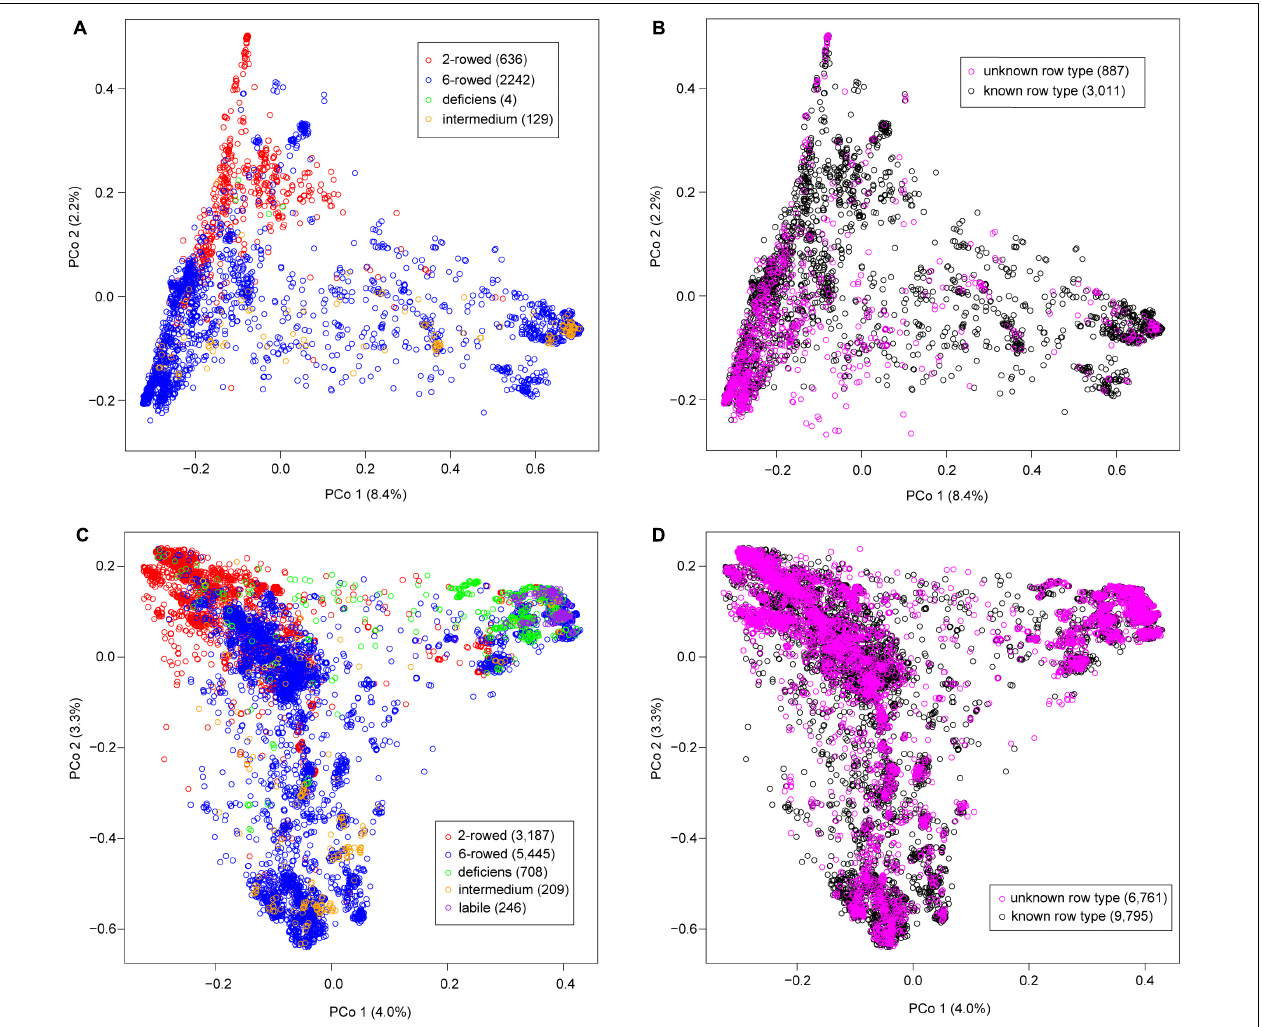
FIGURE 1 | Principal coordinate analysis based on the Rogers’ distance matrix among the 3,898 winter (A,B) and 16,556 spring barley accessions (C,D) . (A,C) The accessions with known row type information were shown in different colors representing the different row types. (B,D) The accessions with unknown row type information were added in magenta, while those with known information were recolored as